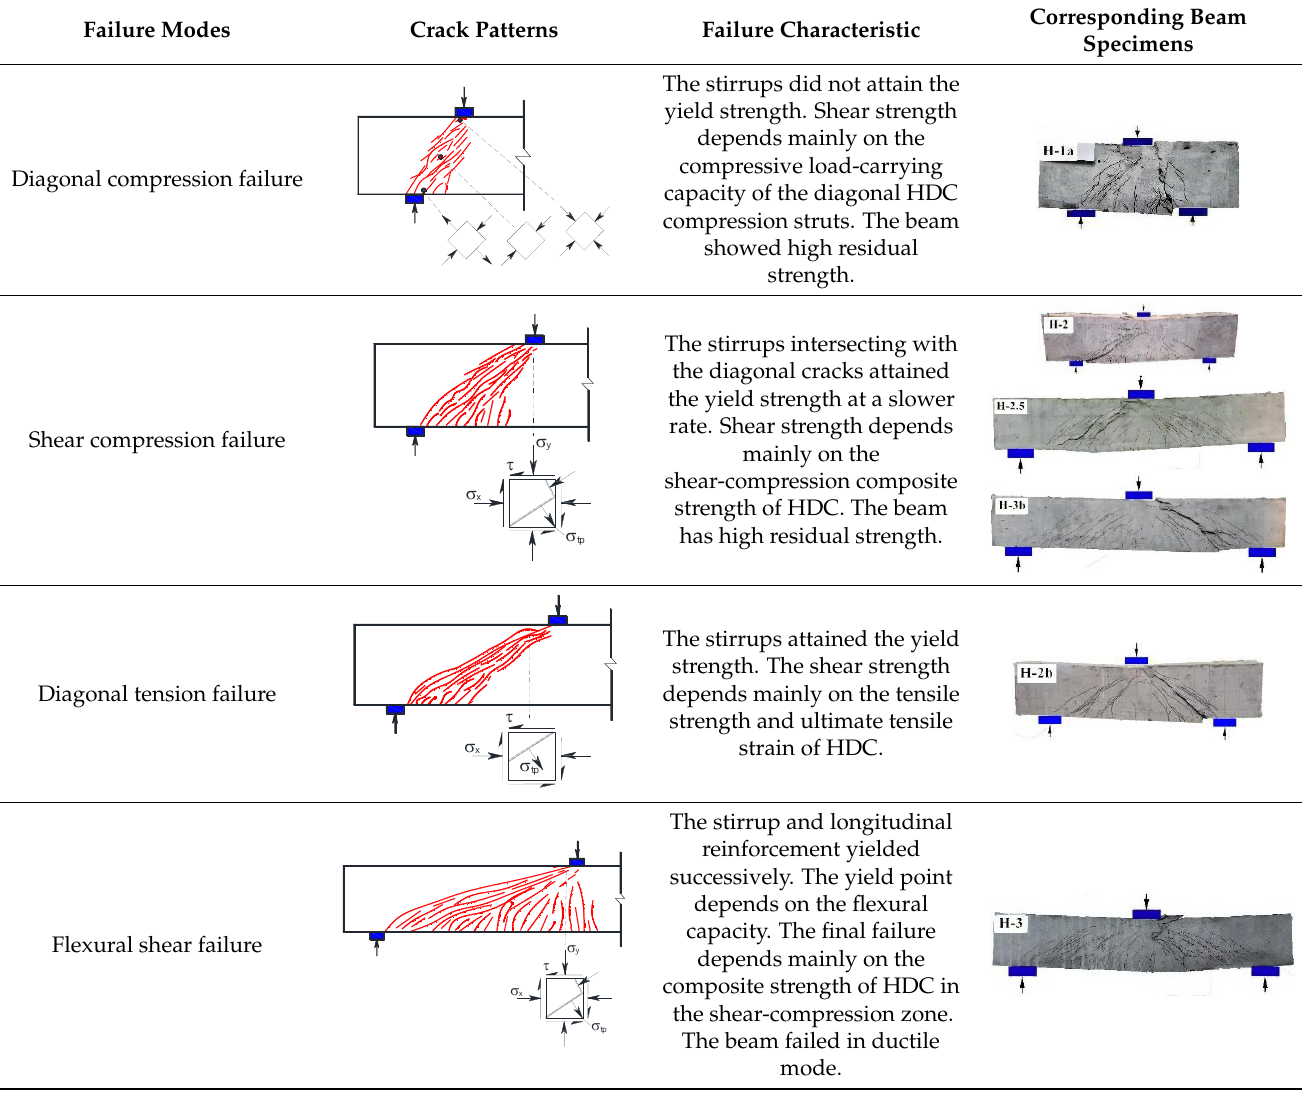
Table 7. Crack patterns and failure modes of RHDC beams.